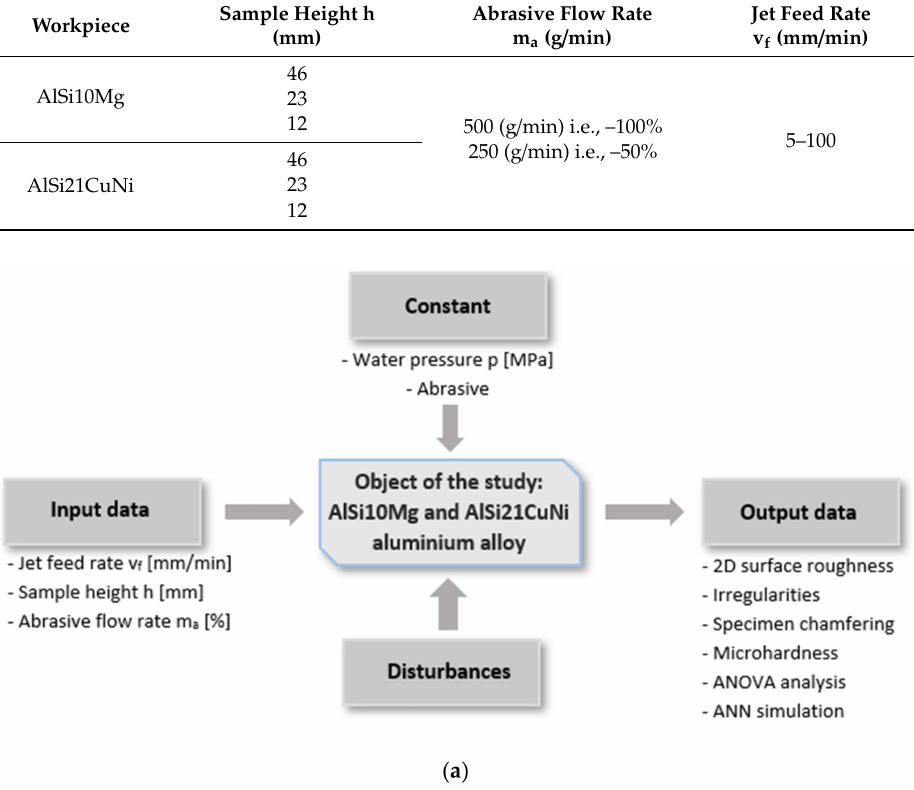
Table 3. Variable technological parameters of AWJ cutting.